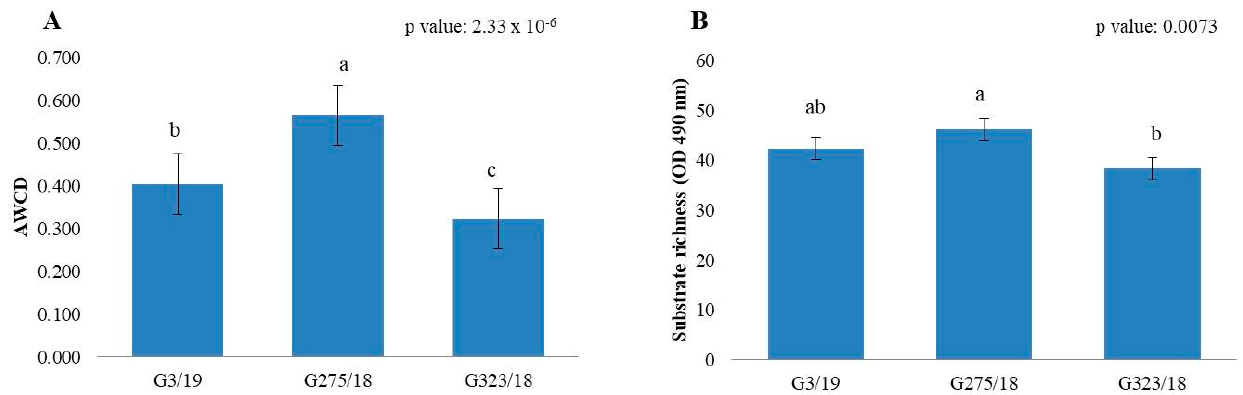
Figure 4. AWCD ( A ) and substance richness ( B ) indices for the three different strains of Botrytis cinerea . Each value is represented with the standard error. The lower-case letters represent the results obtained after applying the post hoc Wilcox test (Tables S14–S18).